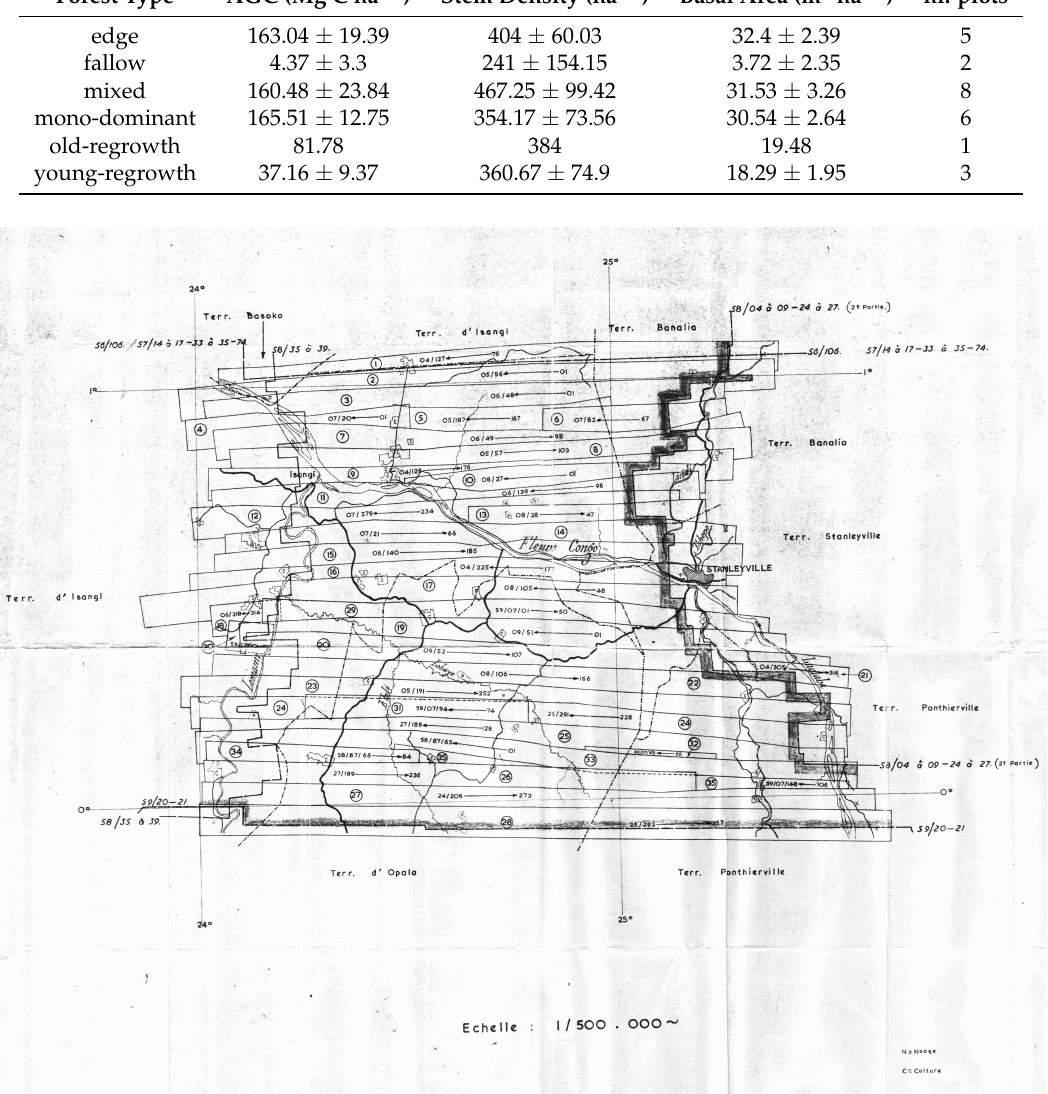
Figure A1. Overview of the complete flight plan of the survey around Kisangani (then Stanleyville) stored in the archives at the Africa